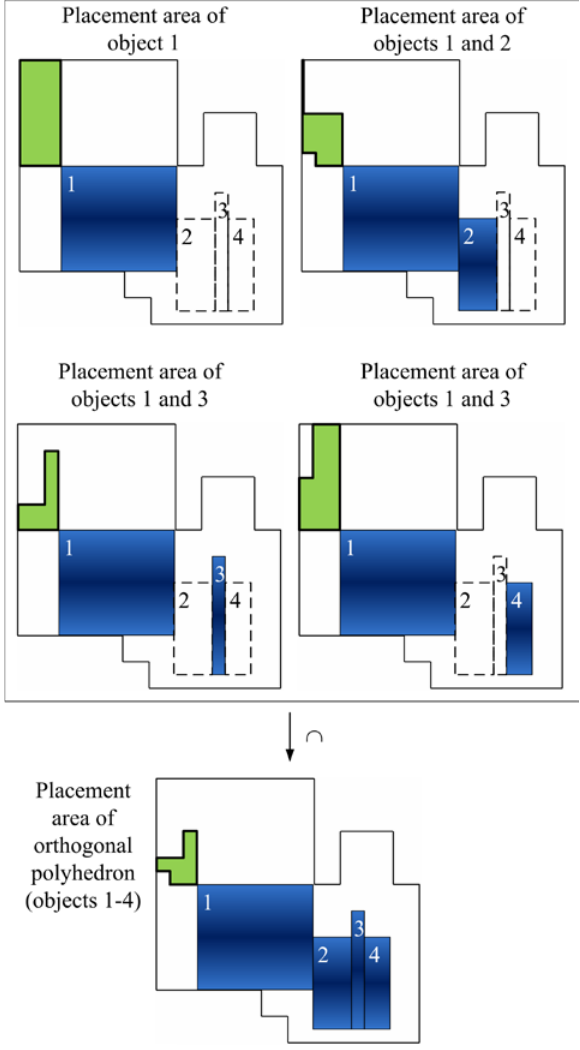
Fig. 8. Finding the admissible area of placement of an orthogonal polyhedron (filled with a gradient fill) in a potential container located in the upper left corner of the container.